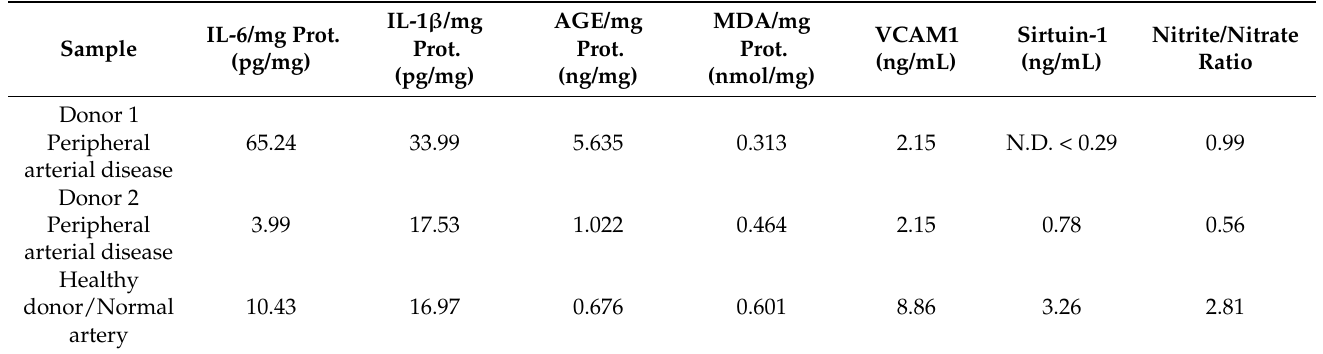
Table 2. Biochemical characterization of the experimental